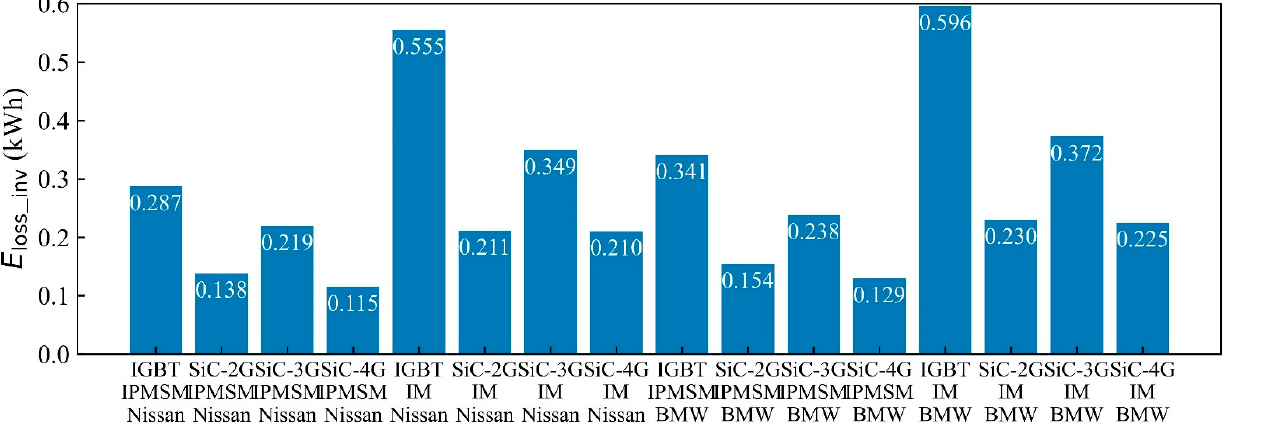
Figure 5. Energy consumption vs. powertrain loss of each phase.